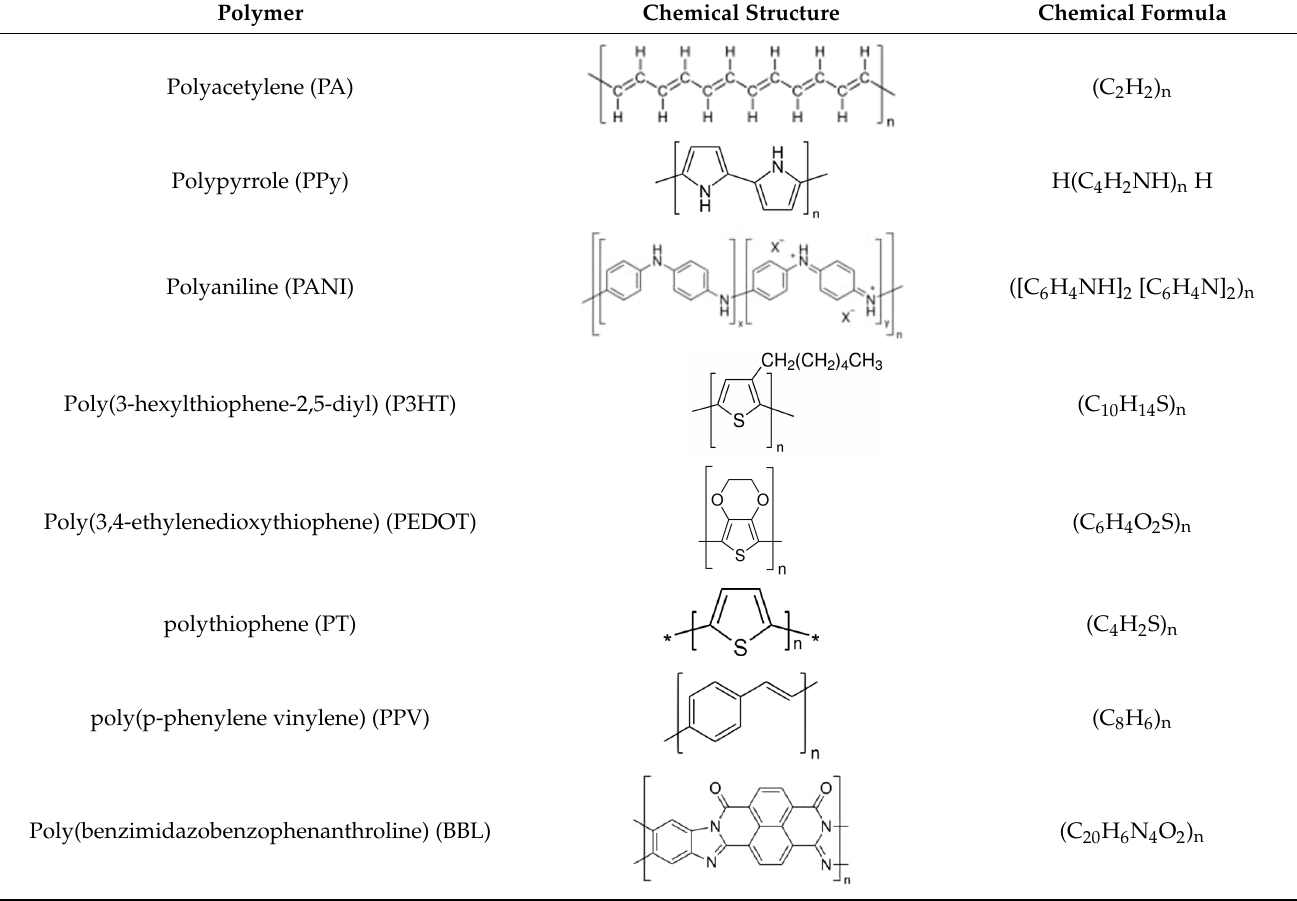
Table 1. Common C-SPs for the electrospinning of nanofibers. Polymer Chemical Structure Chemical Formula